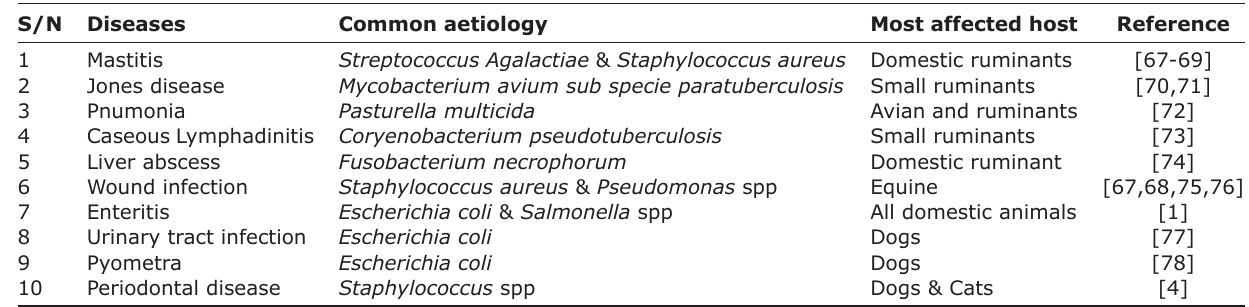
Table-1: Common biofilm diseases in veterinary medicine.